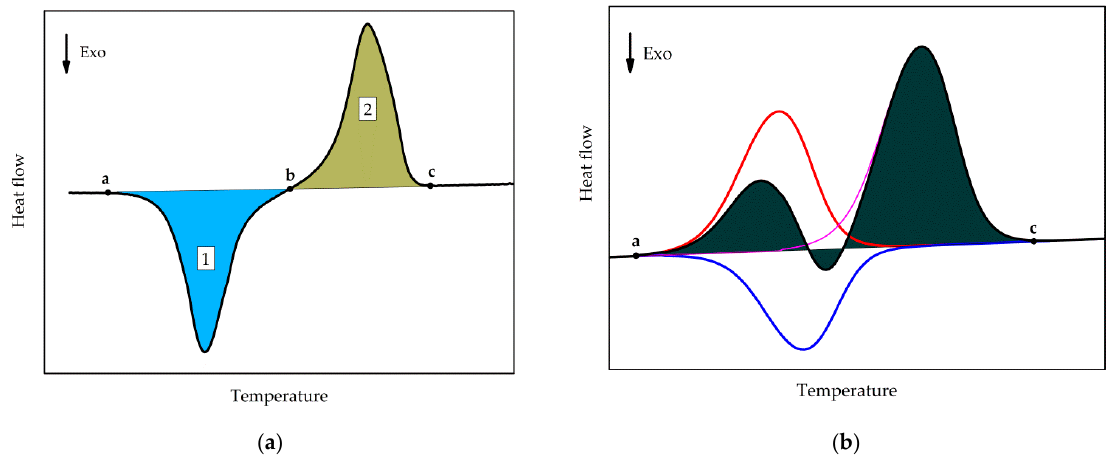
Figure 3. Schematics of ( a ) Determination of the cold-crystallization enthalpy (area of the peak 1) and overall latent heat (sum of the areas of peaks 1 and 2). ( b ) Determination of the overall latent heat (shaded area), red curve: melting of tiny polymer crystals, blue curve: recrystallization effect, magenta curve: melting of the re-crystallized polymer crystals.